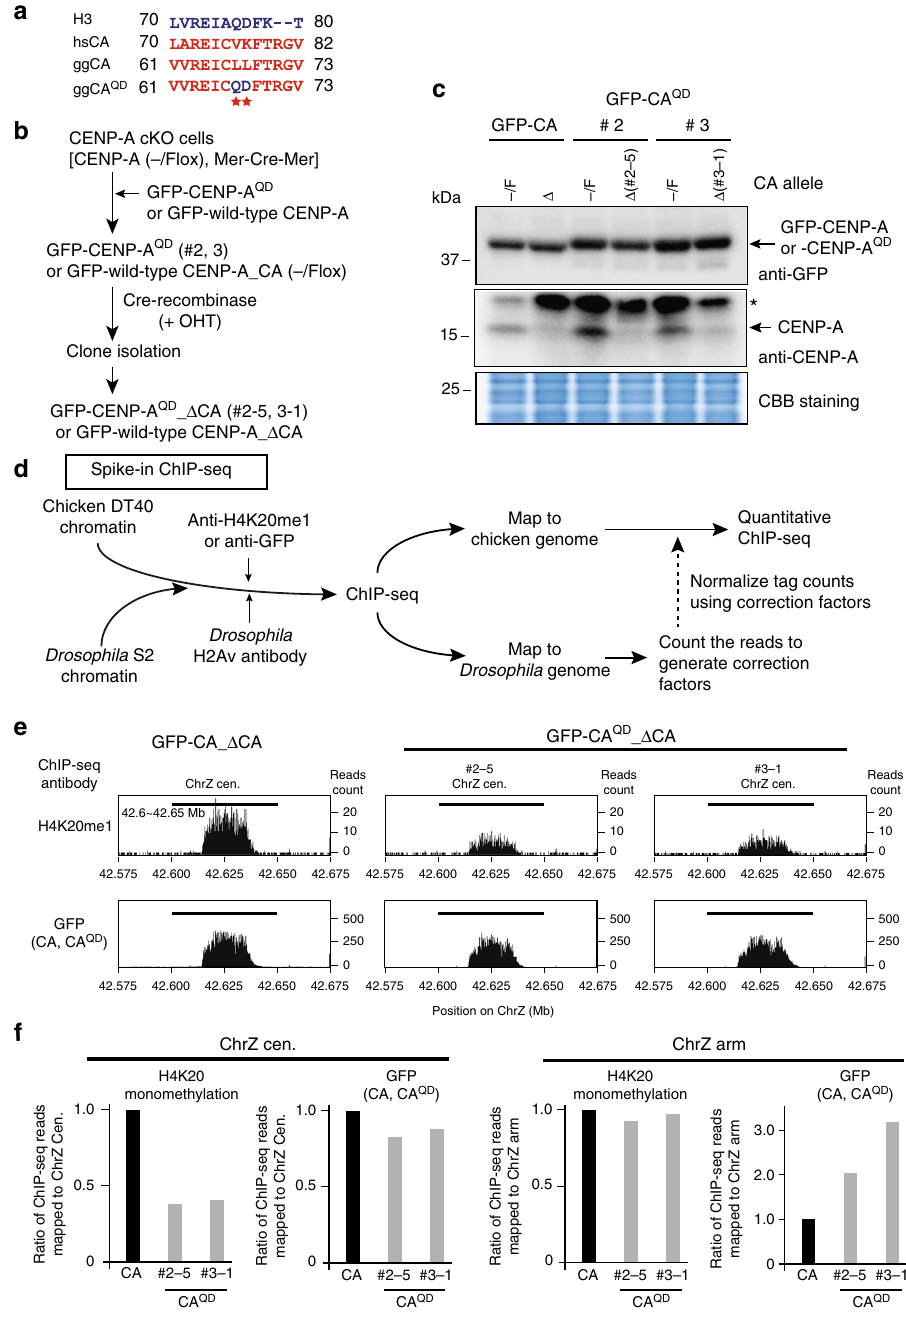
Fig. 4 CENP-A QD mutation causes reduced H4K20 monomethylation in the DT40 centromere. a Alignment of the amino acid sequences of human histone H3.1, human CENP-A (hsCA), chicken CENP-A (ggCA), and chicken CENP-A QD (ggCA QD ). The amino acid residues corresponding to the human CENP-A V76 and K77 residues are the chicken CENP-A L67 and L68 residues, respectively. b Experimental design to create CENP-A-de fi cient cells expressing either GFP-tagged CENP-A or CENP-A QD . c Immunoblot analyses with anti-GFP (Upper panel) and anti-CENP-A (Middle panel) antibodies, using whole- cell protein extracts from cells expressing GFP-tagged CENP-A (GFP-CA) or CENP-A QD before (-/F) and after ( Δ ) the endogenous CENP-A knockout. Two-independent cell lines were used for cells expressing CENP-A QD [#2 and #3]. Endogenous CENP-A depletion was con fi rmed (Middle panel). The asterisk indicates non-speci fi c bands. Coomassie Brilliant Blue (CBB) staining is shown as a loading control (Lower panel). d Schematic representation of the Spike-in ChIP-seq. e Normalized ChIP-seq pro fi les with anti-H4K20me1 (Upper panels) and anti-GFP (Lower panels) around the centromere region on chromosome Z (42.575 – 42.675Mb) in CENP-A-de fi cient DT40 cell lines, expressing either GFP-CENP-A (Left side panels) or GFP-CENP-A QD (#2-5; Middle and #3-1; Right panels). The centromeric accumulation of H4K20me1 was reduced in the cells expressing GFP-CENP-A QD (Upper middle and right panels). f Ratio of normalized ChIP-seq reads mapped to the chromosome Z centromere (ChrZ cen.: 42.6 – 42.65 Mb, Left two graphs). Ratios of reads mapped to the non-centromeric chromosome Z arm are also shown (ChrZ arm, Right two graphs). The reads of H4K20me1 mapped to the centromeric region in the GFP-CENP-A QD #2-5 and #3-1 cell lines were reduced to 0.38 and 0.41, respectively, as compared to the reads in cells expressing GFP-CENP- A. The mapped reads to the arm region were similar in both cells expressing GFP-CENP-A and GFP-CENP-A